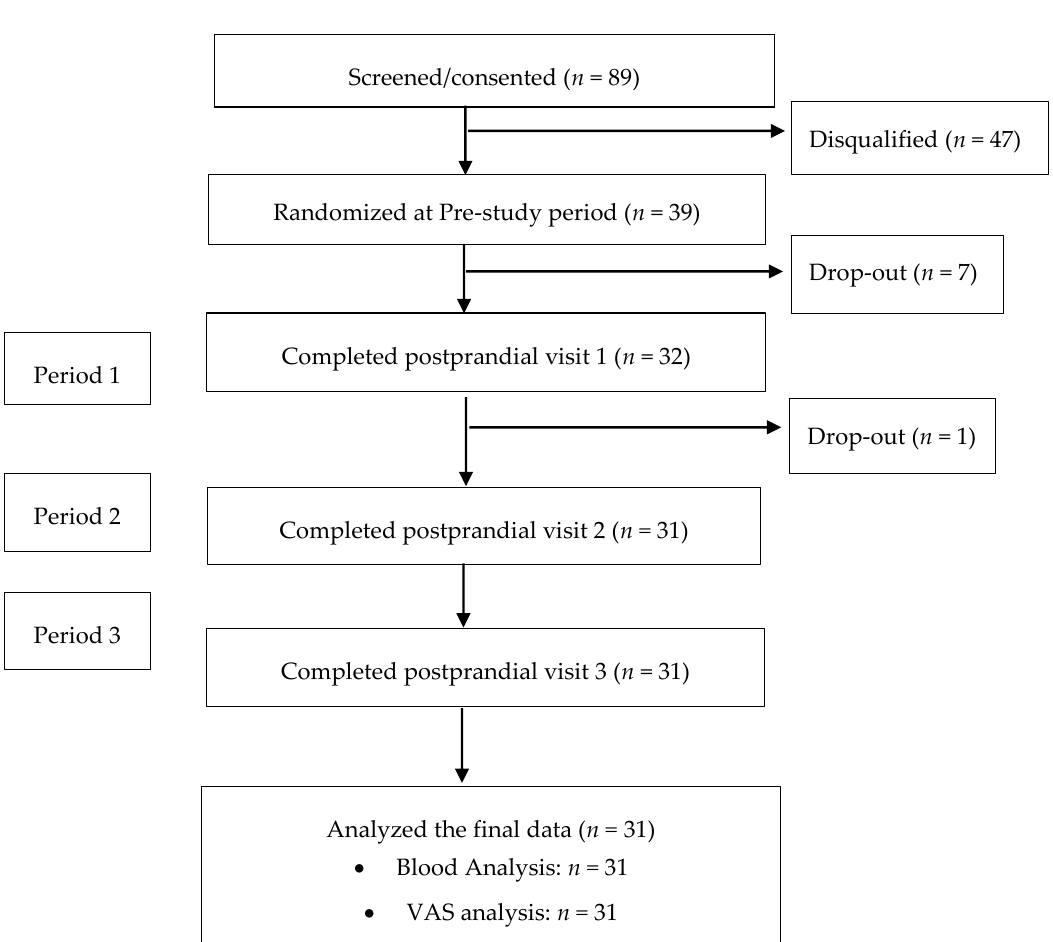
Figure 1. Consolidated Standards of Reporting Trials (CONSORT) flow diagram of the study. VAS, visual analog scale.